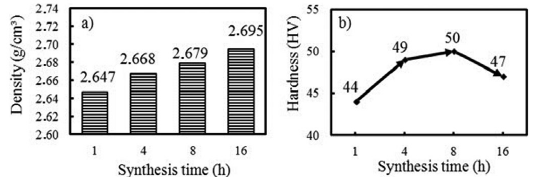
Figure 4. Density (a) and hardness change (b) of A356+ 6% Ti AMCs depending on different synthesizing durations.